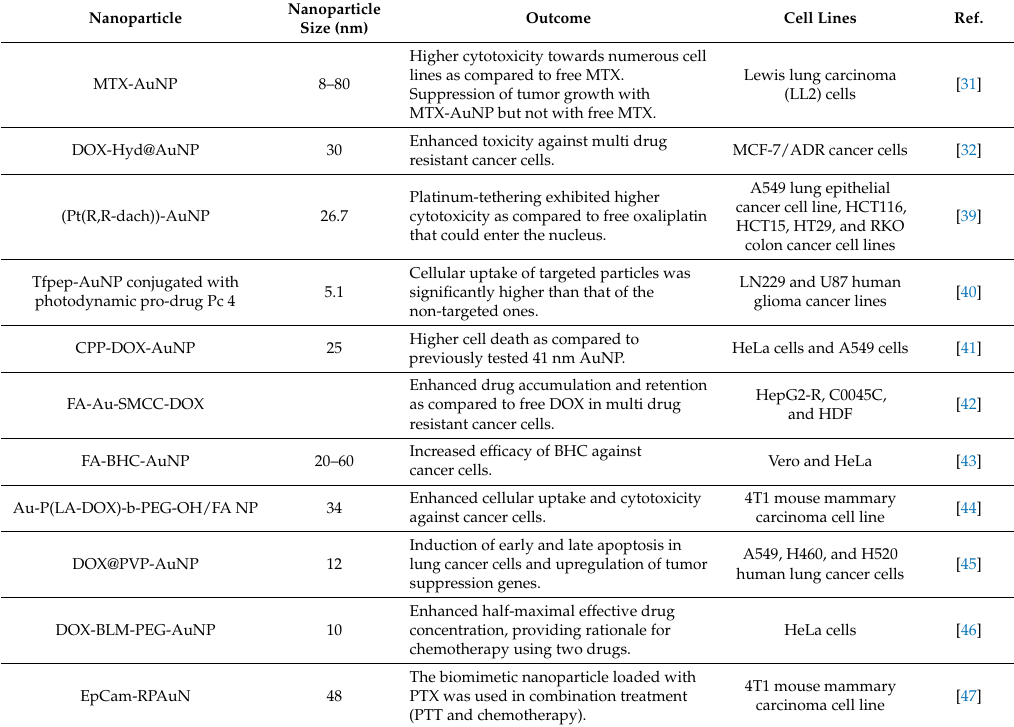
Table 1. Anti-tumor applications of gold nanoparticles in drug delivery.